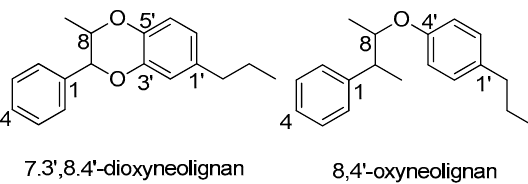
Figure 15. Subtypes of oxyneolignans.